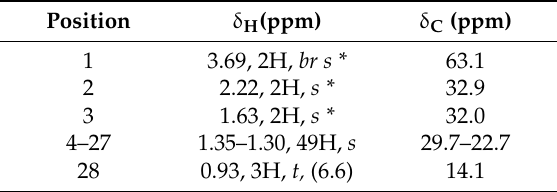
Table 3. 1 H (300 MHz) and 13 C (75 MHz) NMR spectra of 16 in CDCl 3 .